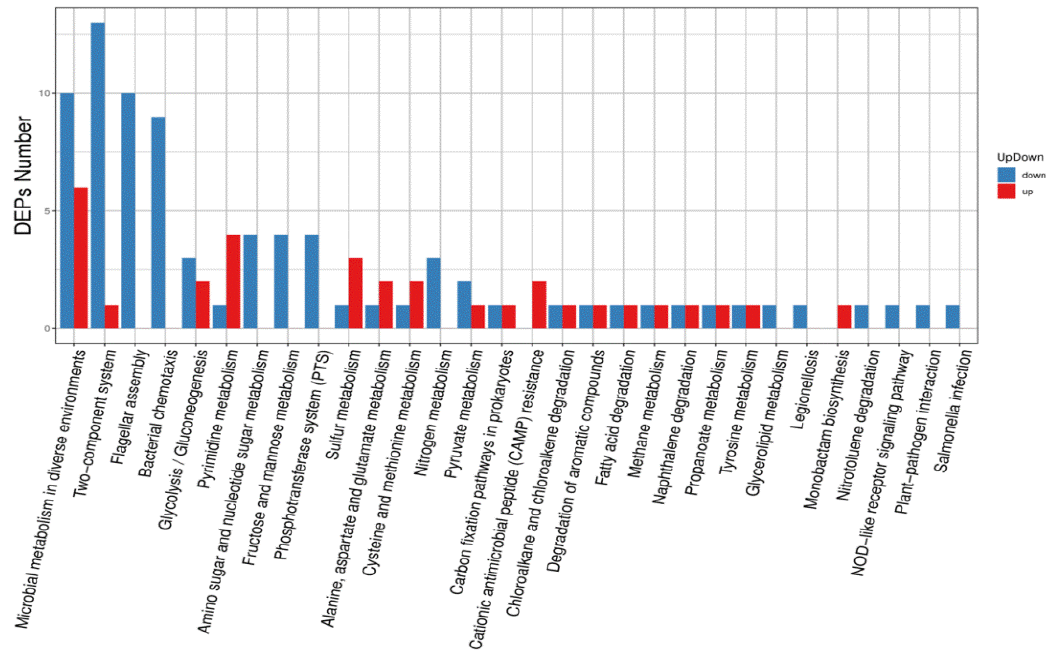
Figure 6. Up-regulated and down-regulated differentially expressed protein pathway classifica- tion.